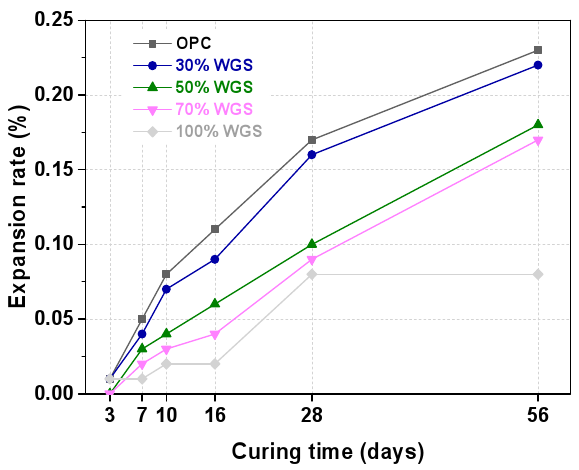
Figure 12. Expansion rate of mortar bars with WGS substituting 0%, 30%, 50%, 70%, and 100% of sand.